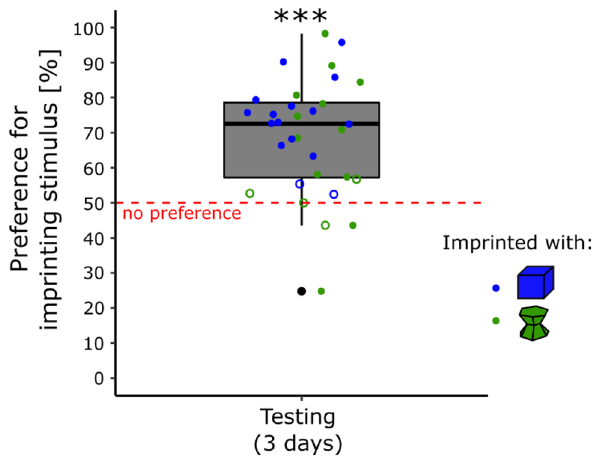
Figure 2. In experiment 2, the preference for the imprinting stimulus was stable across days for both conditions (p < 0.001, ***). The blue dots represent the preference score of the chicks imprinted with the blue stimulus. The green dots represent the preference score of the chicks imprinted with the green stimulus. Filled dots show the individuals having a significant preference while empty dots show the individuals having no preference. The asterisks represent the overall significance of both conditions pooled, against no preference.